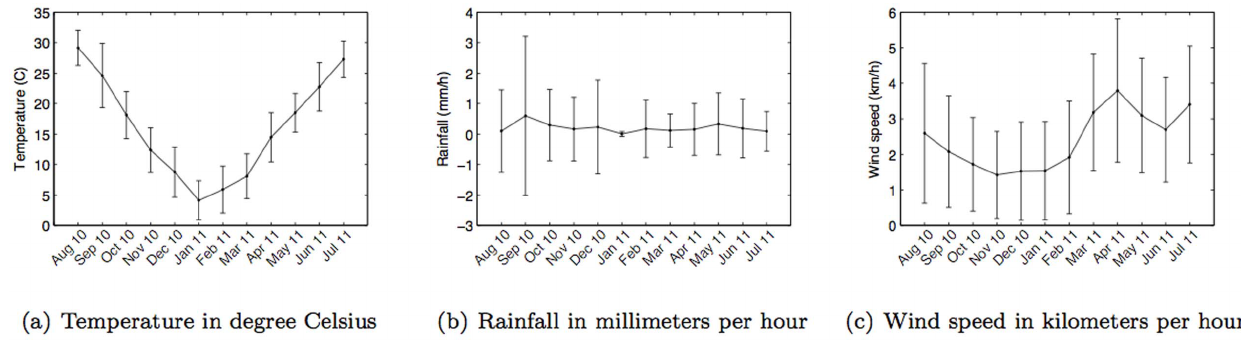
Figure 4. Monthly weather conditions in Tokyo during the period of the analysis.